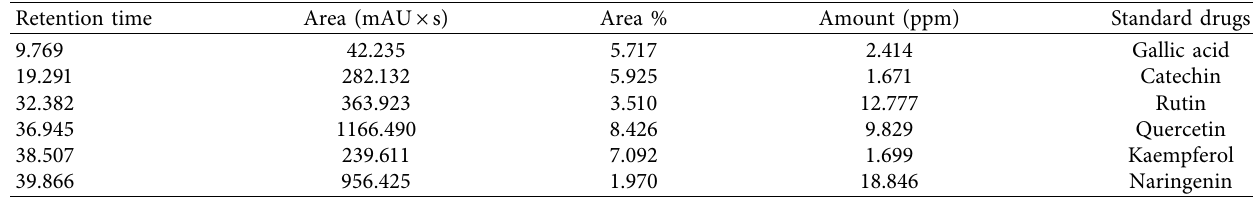
Figure 4: HPLC chromatograms of identified peaks of (a) hydromethanolic leaf extract of SL at 280nm and(b) a mixture of standard flavonoids at 280nm. Table 2: Retention time and identification of the peaks of hydromethanolic leaf extract of SL.